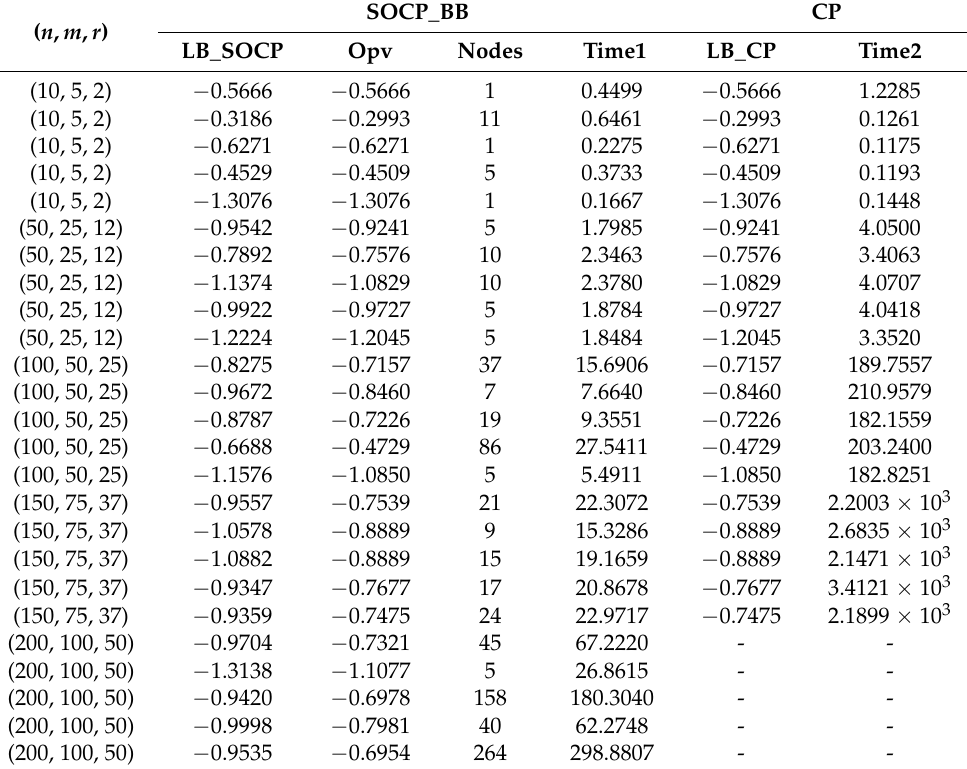
Table 3. Performance Comparisons of the enhanced SOCP relaxation and the CP relaxation with (cid:99) and r = (cid:98) n (cid:99) m = (cid:98) n 2 4